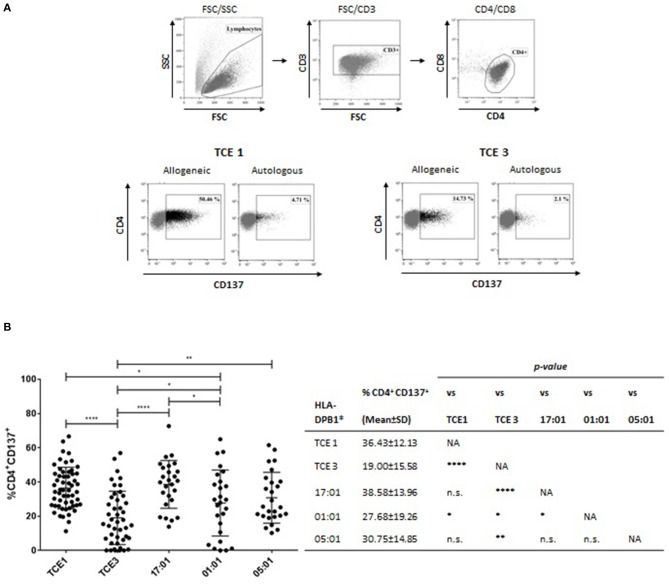
T-cell allorecognition of HLA-DPB1 from different TCE groups expressed by HeLa-II. PBMC from HLA-DPB1 TCE 1-negative responders carrying at least one HLA-DPB1 TCE 3 were stimulated with irradiated HeLa-II transduced with allogeneic HLA-DPB1 TCE 1 or TCE 3 for 14 d, as described in Materials and Methods. For HLA-DPB1 typing of responders see Table 2. Cultures were re-stimulated for 24 h with HeLa-II expressing the original allogeneic HLA-DPB1, or with autologous HLA-DPB1, and the percentage of CD4+ T cells expressing the CD137 activation marker was assayed by flow cytometry. (A) Gating strategy and representative FACS plots for re-stimulation with autologous HLA-DPB1 or with allogeneic HLA-DPB1 from TCE 1 or TCE 3. Note the higher percentage of CD137+ CD4+ T cells in response to TCE 1 compared to TCE 3. (B) Results of CD137 assays in response to TCE 1, TCE 3 or HLA-DPB1*17:01, *01:01 or *05:01 for a total of 178 independent co-cultures. Statistical comparisons were performed by the two-tailed unpaired t-test (*p < 0.05; **p < 0.01; ****p < 0.0001).